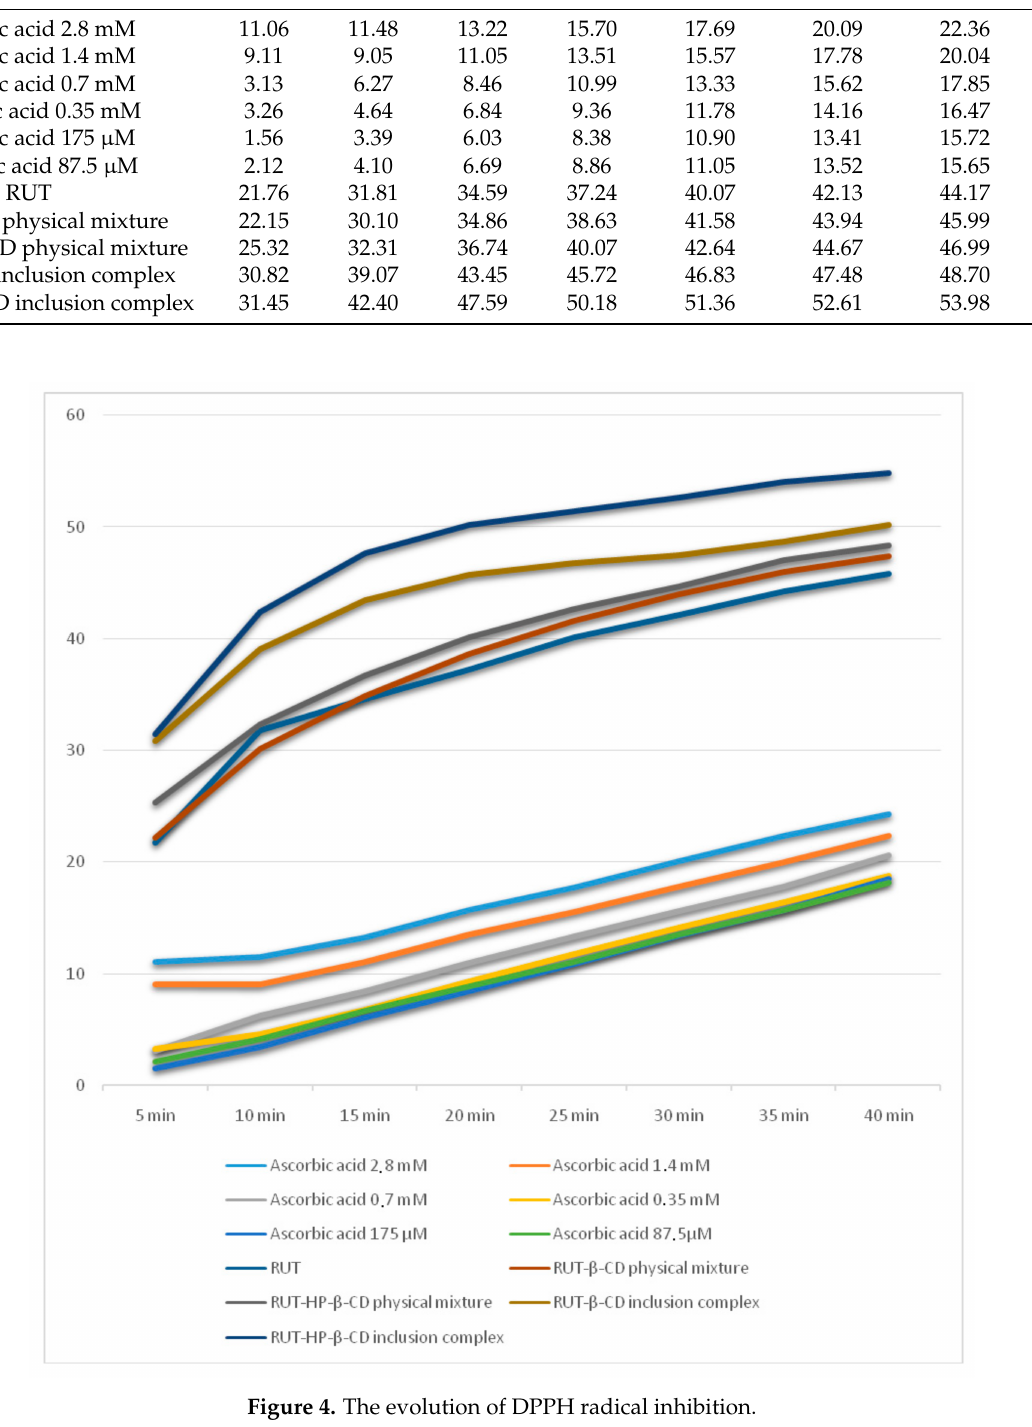
Figure 4. The evolution of DPPH radical